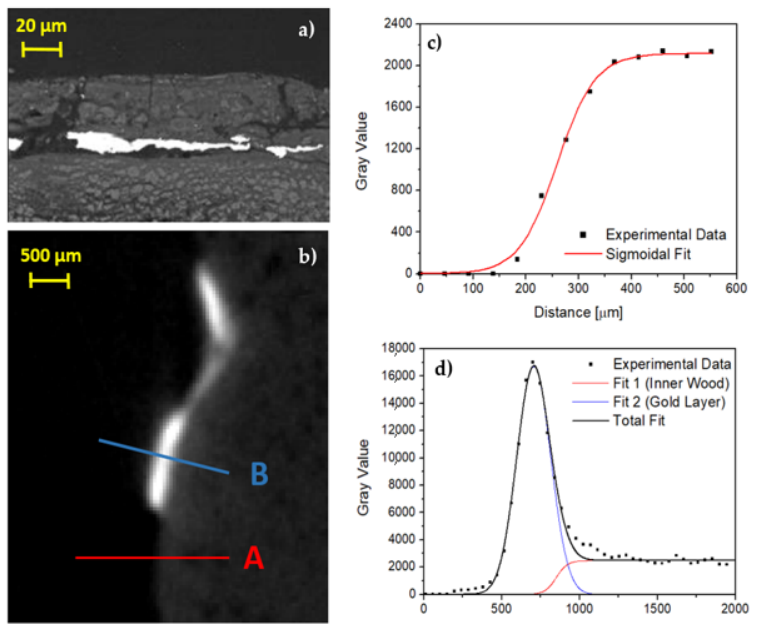
Figure 8. ( a ) Backscattering image by means of SEM, the gold layer is in light gray; ( b ) enlargement of Figure 5c; ( c ) profile plot along A line shown in ( b ), only wood; ( d ) profile plot along B line shown in ( b ), gold on thin preparation layer.